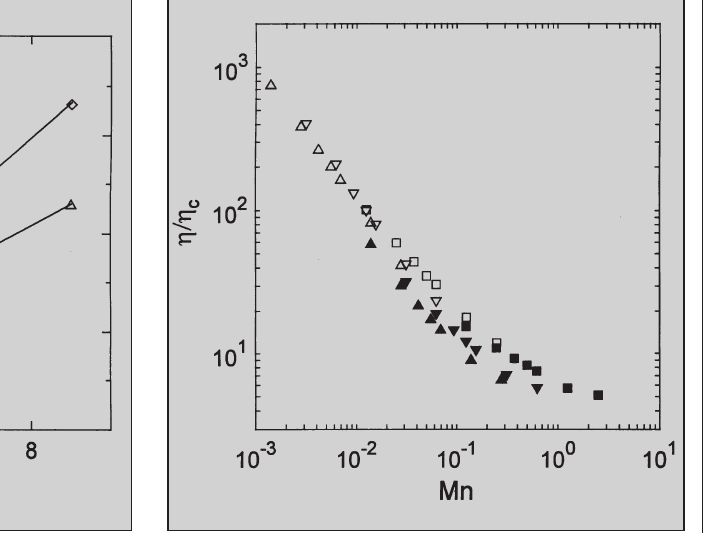
Dependence of the yield stress, τ o , of the suspensions in SO 100 ( Ô ) and SO 1000 strength E 2 at the shear